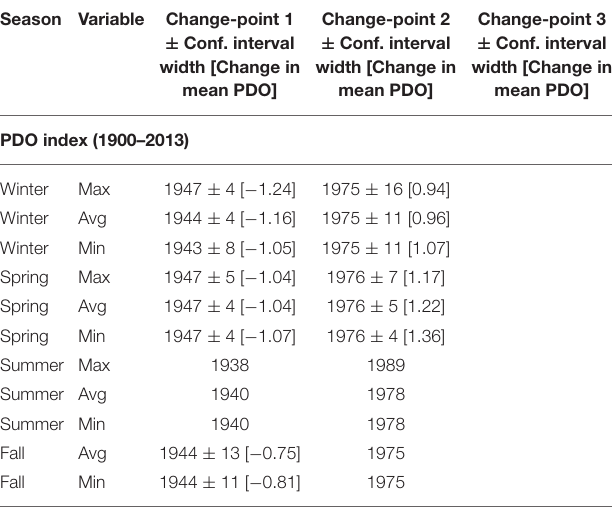
TABLE 3A | Change-points in mean for station JIA representing southeastern region of Alaska with: PELT change-point estimate ± width of approximate 95% confidence interval (when change detection test p -value < 0.05) and [amount of change in mean in ◦ C], or only PELT change-point estimate (when change detection test p -value > 0.05).